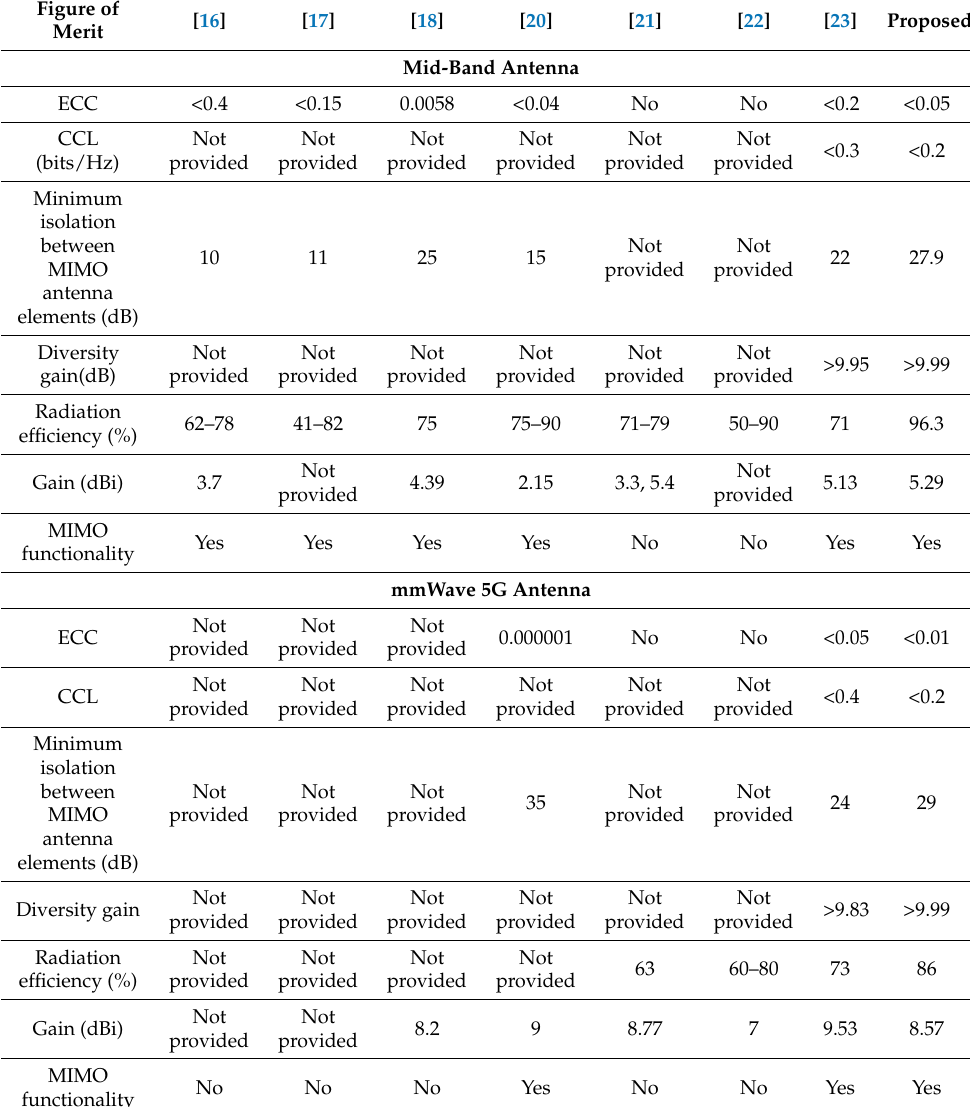
Table 3. Comparison of the proposed design with the relevant literature. Figure of